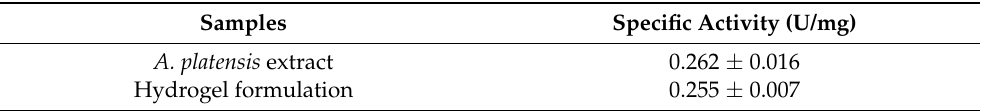
Table 2. Specific activity (U/mg) of the A. platensis lysate using azocasein as a substrate, before and after the hydrogel formulation. The data represent the mean ± SD (N =